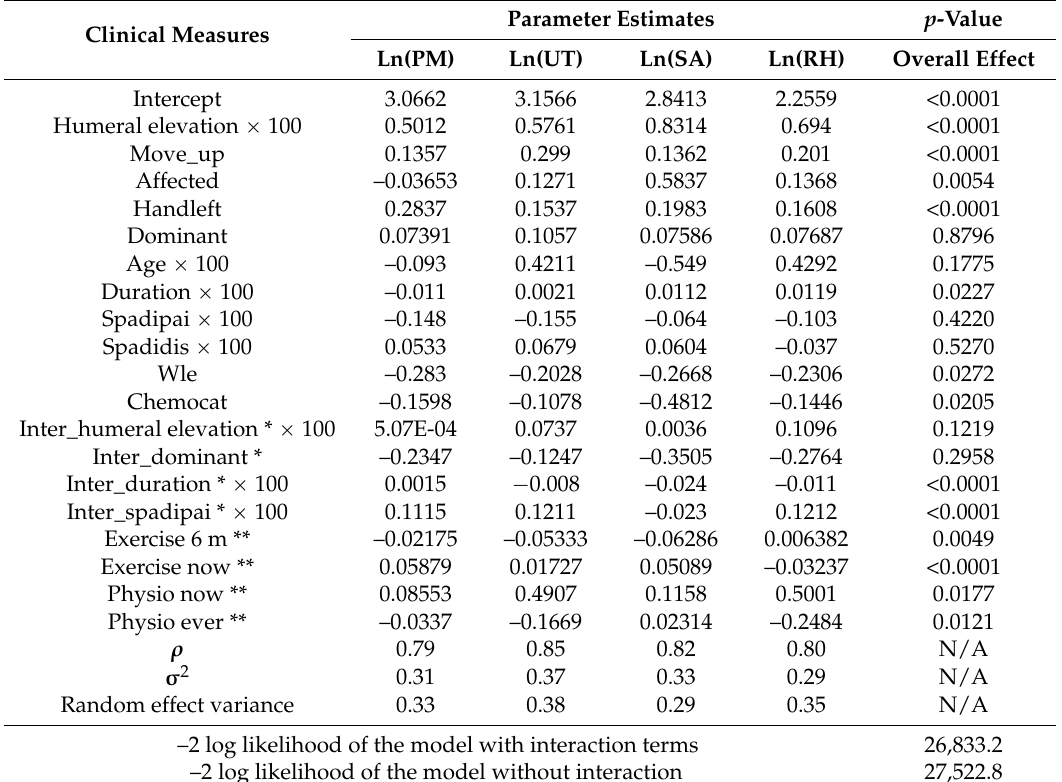
Table 3. Result of the analysis using multivariate Linear Mixed Model with AR(1) structure for Σ k